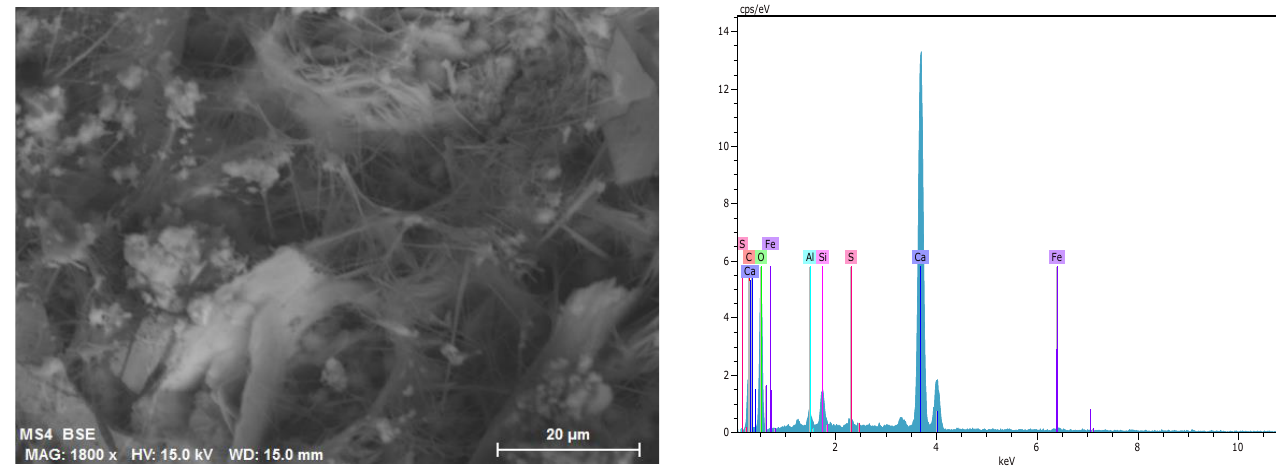
Figure 9. Microfissures filling with new ettringite-type hydration products.